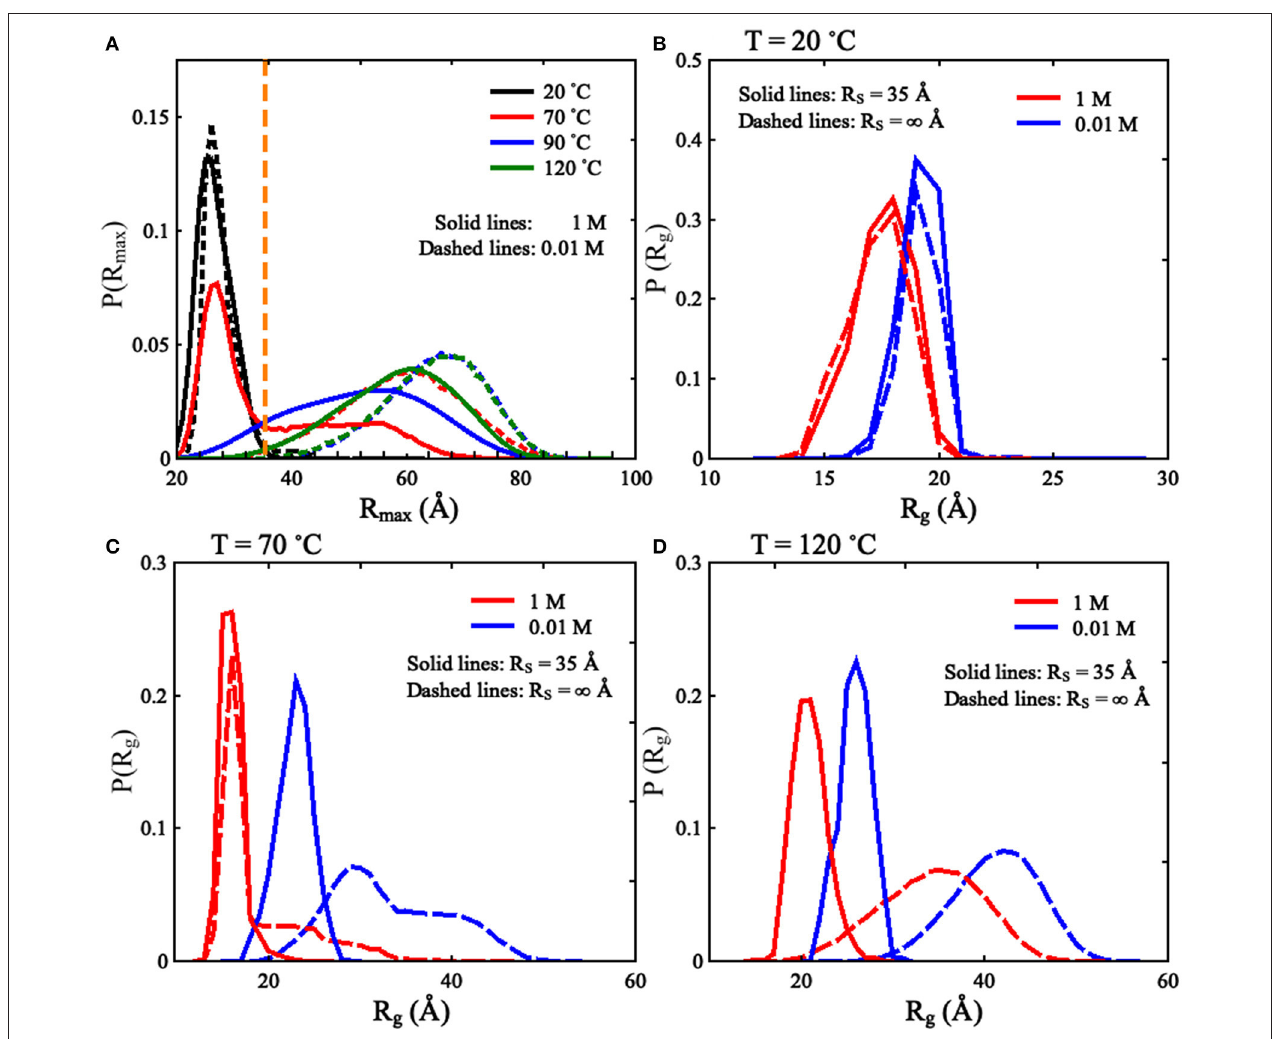
FIGURE 3 | (A) The distributions of R max [maximal distance between coarse-grained (CG) beads and their centroid] for the mouse mammary tumor virus (MMTV) pseudoknot at different temperatures and 1M [Na + ], and the vertical dashed line represents R max of 35 Å. (B–D) The distributions of R g for the conformations of the MMTV pseudoknot at different [Na + ]s and temperatures: (B) 20 ◦ C, (C) 70 ◦ C, and (D) 120 ◦ C. In (B–D) , the solid lines and dashed lines represent R S = 35 Å and R S = ∞ Å,